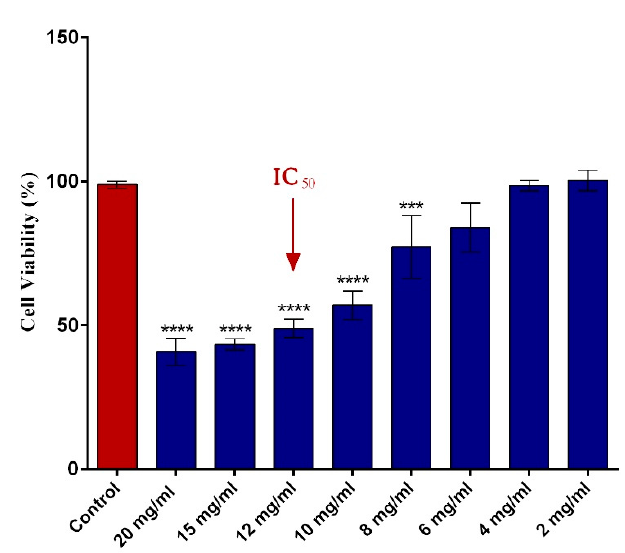
Figure 4. Human adenocarcinoma HT–29 cell viability after 24 h incubation with various concen- trations (2–20 mg/mL) of 5-FU PEGylated SF NPs (**** p ≤ 0.0001 sample vs. untreated control; *** p ≤ 0.001 sample vs. untreated control). The red arrow indicates the 5-FU SF/PEG NPs concentra- tion corresponding to the IC 50